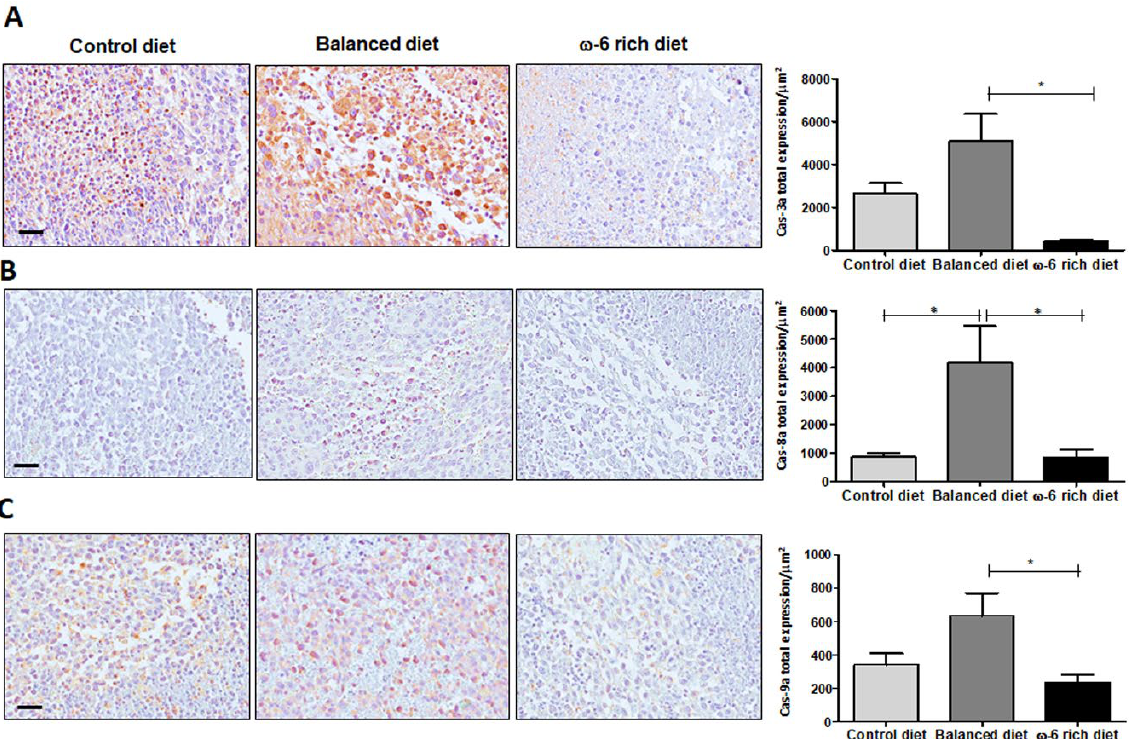
Figure 3. High consumption of PUFA ω -6 inhibits caspase-3, -8 and -9-dependent apoptosis. ( A ) Representative photomicrographs and analysis of active caspase-3 expression analyzed by immuno- histochemistry, (* p < 0.05). ( B ) Active caspase-8 immunostaining, (* p < 0.05). ( C ) Active caspase-9 immunostaining, statistical differences are shown (* p < 0.05). Scale bar: 20 μm. Data are